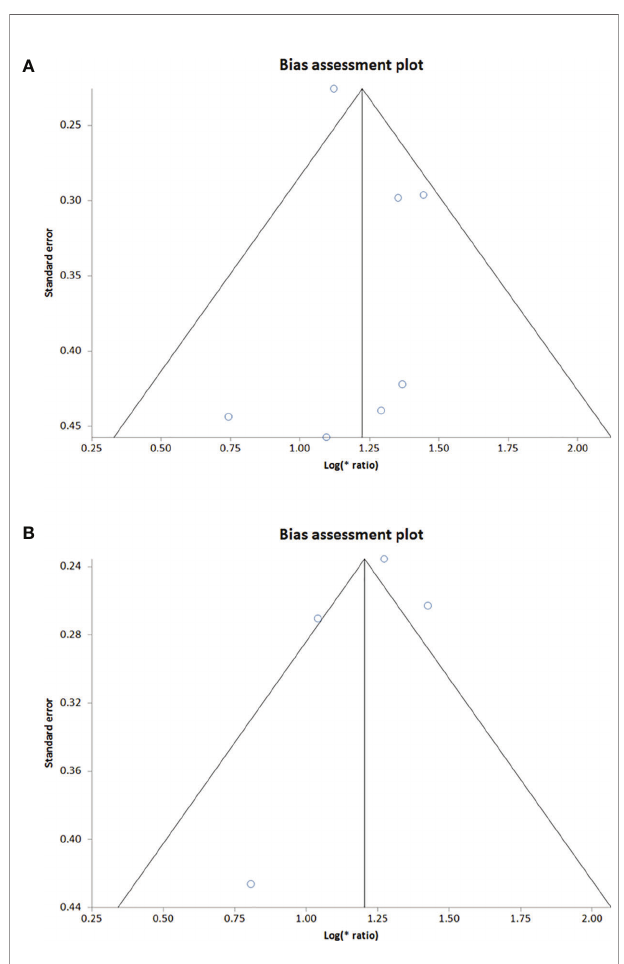
FIGURE 6 | Begg ’ s funnel plot showing publication bias of upregulated (A) univariate analysis & (B) multivariate analysis. Each dot of the Begg ’ s funnel plot represents a separate study. The two border lines of the plot represent the pseudo 95% con fi dence intervals against their corresponding standard errors and the middle solid line indicates the overall effect from the meta-